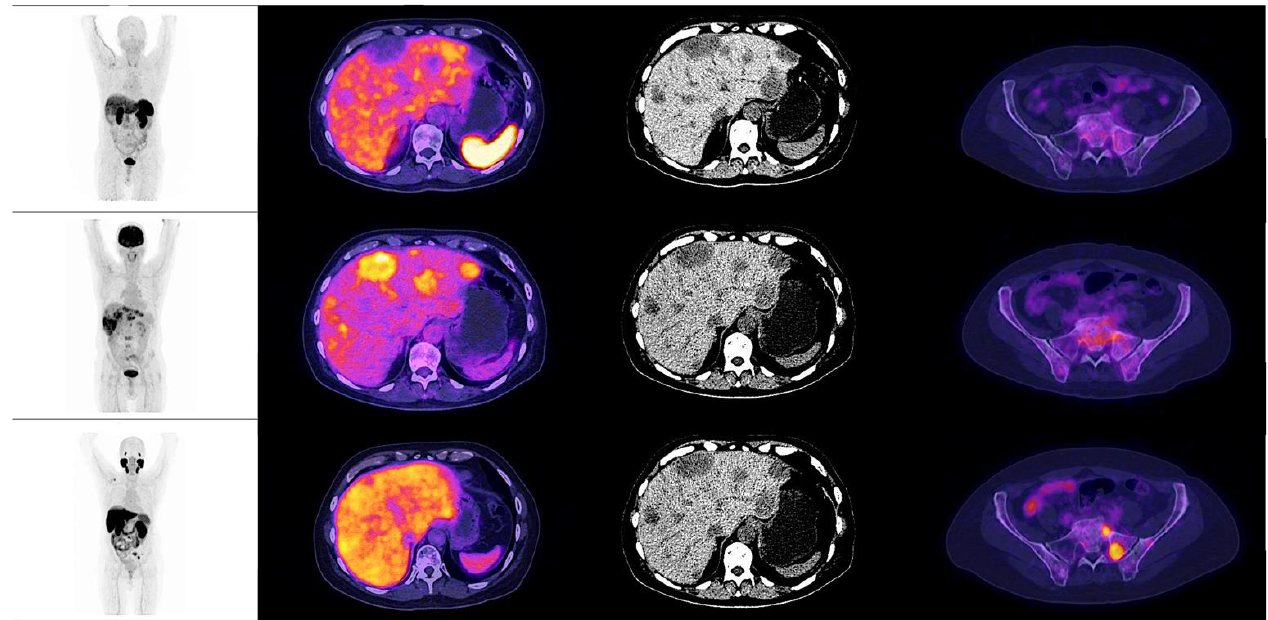
Figure 3. Percentage of lesions detected by 18 F-PSMA-1007, 18 F-FDG and 18 F-AlF-Nota Octreotide by regions.